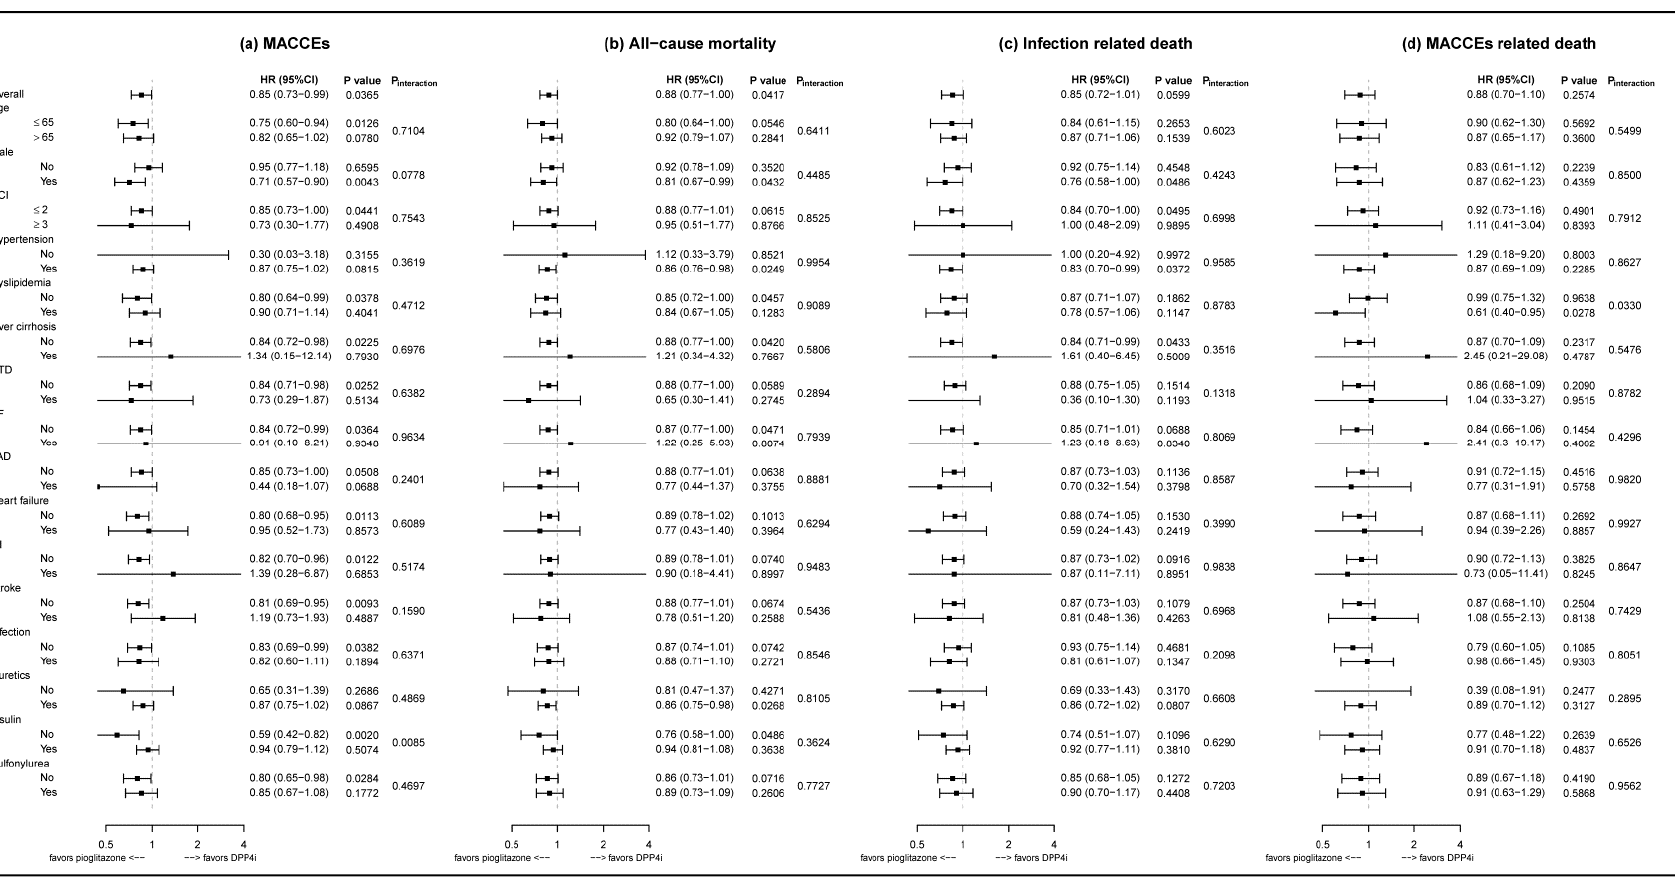
Figure 3. Forest plot of subgroup analysis for primary and secondary outcomes. ( a ) Major adverse cardiac cerebrovascular events; ( b ) All-cause mortality; ( c ) Infection related death; ( d ) Major adverse cardiac cerebrovascular events (MACCEs) related death. AF, atrial fibrillation; CCI, Charlson’s cormobidity index; CI, confidence interval; CTD, connective tissue disease; DPP4i, dipeptidyl-peptidase 4 inhibitors; HR, hazard ratio; MI, myocardial infarction; PAD, peripheral artery disease .